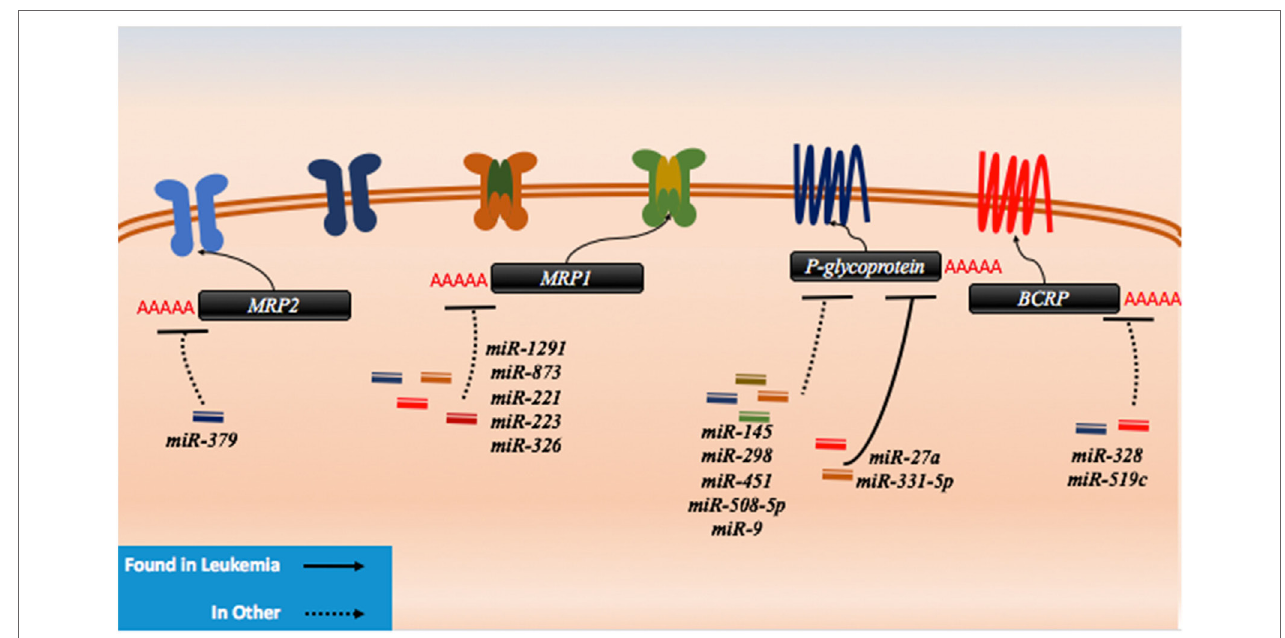
FigURe 6 | microRNAs (miRNAs) have been shown to dysregulate drug efflux mechanisms in both leukemia and other cancer. There are no known miRNA regulators of the drug influx proteins. In leukemia, P-glycoprotein has been demonstrably targeted by miR-27a and miR-331. In other cancers, P-glycoprotein has been shown to be regulated by miR-145, miR-298, miR-451, miR-508-5p, and miR-9. MRP1 has been targeted by miR-1291, miR-873, miR-221, miR-223, and miR-326, while MRP2 has been shown to be targeted my miR-379. The last protein to exhibit miRNA binding in lab setting is BCRP which has been shown to be a target of miR-328 and